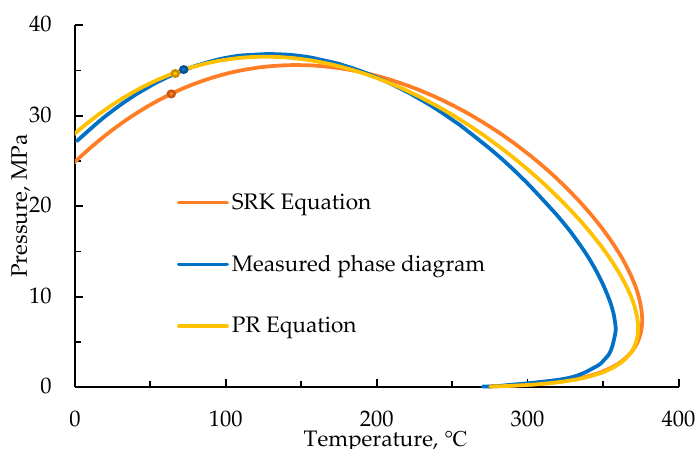
Figure 1. Comparison of predicted phase diagrams of PR EOS and SRK EOS.